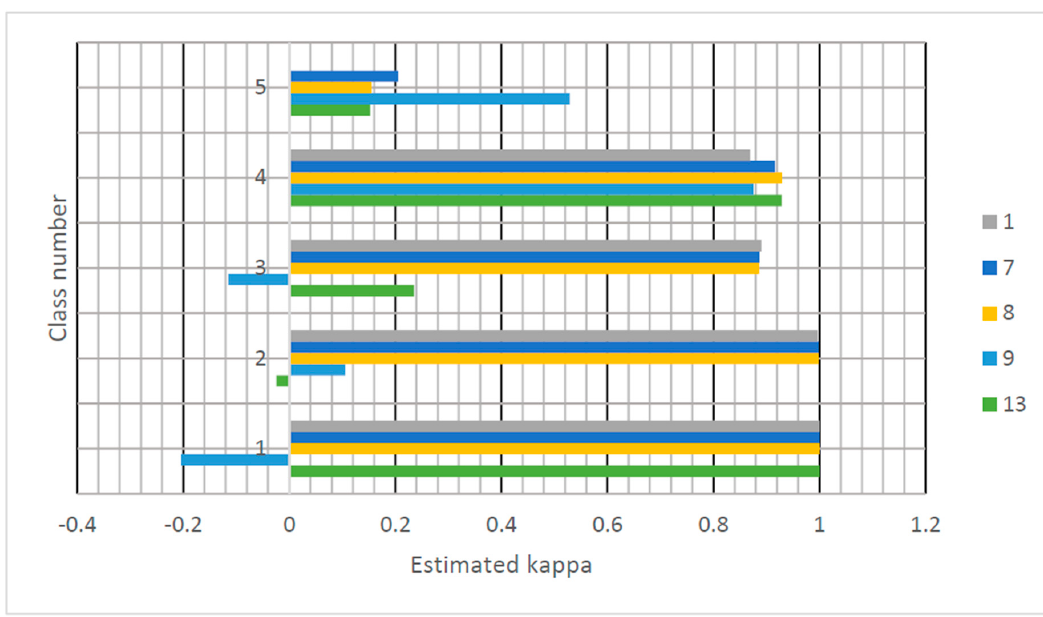
Figure 6. The estimated kappa for the Osijek study area.